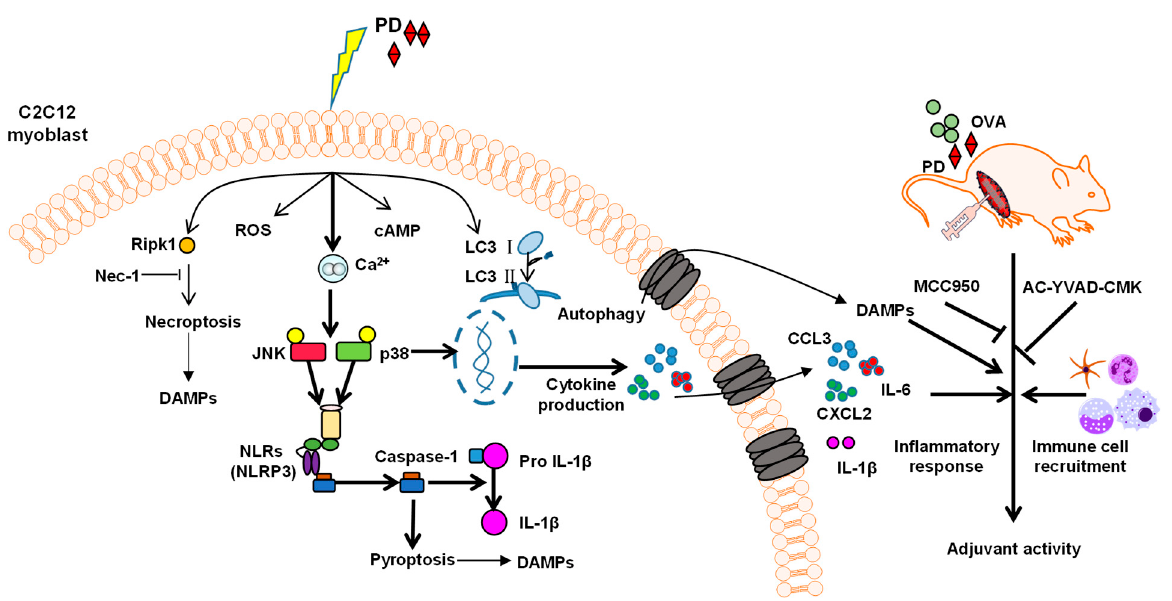
Figure 9. Proposed mechanisms of adjuvant action of PD. PD can induce necroptosis, pyroptosis, and autophagy in C2C12 myoblasts. Caspase-1-dependent pyroptosis mediated the inflammatory response in the C2C12 cells and was regulated by Ca 2+ − JNK/p38 MAPK − NLRP3 in fl ammasome sig- naling. The inflammatory cytokines and DAMPs released from the dying cell promoted the recruit- ment of immune cells into the injection site, leading to overall strongly enhanced adaptive immune responses in vivo.